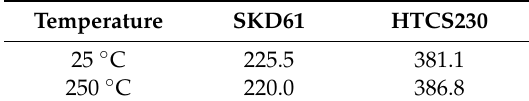
Table 2. Micro-vickers hardness value (HV 1).